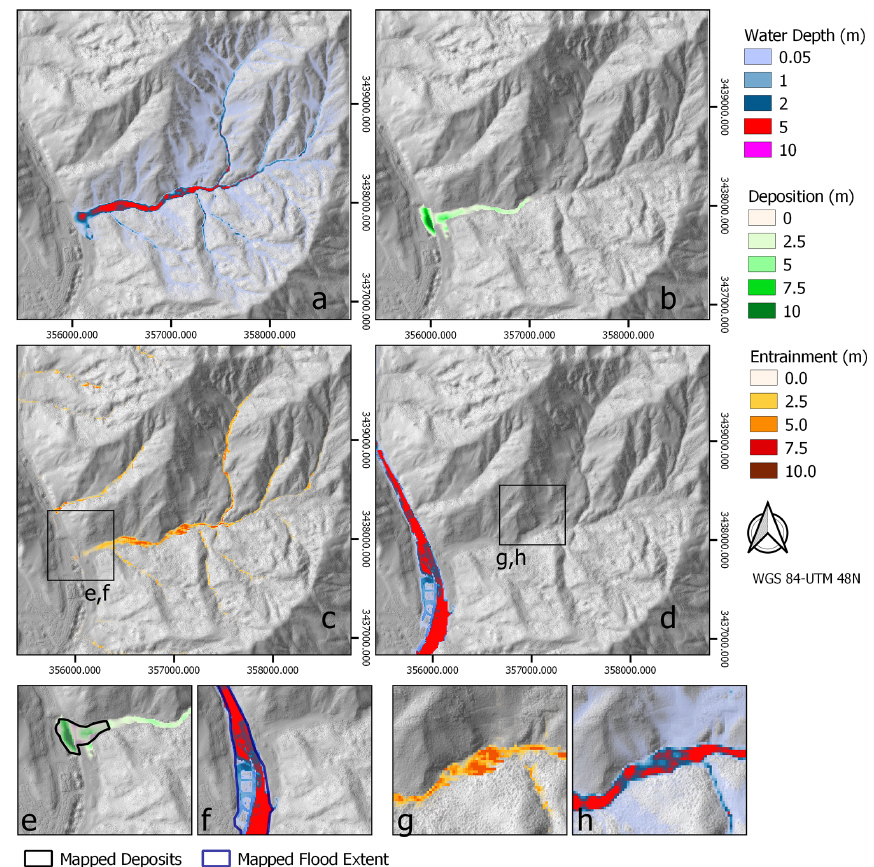
Figure 11. Calibrated simulation results for the second chain in the Hongchun watershed. (A) Maximum total flow depth. (B) Final deposit depth. (C) Entrainment depth. (D) River flood depth. (E, F) Zoom of Hongchun outlet with (E) deposition depth compared with mapped extent and (F) river flood depth compared to mapped flood extent. (G, H) Zoom of Hongchun landslide dam with (G) entrainment depth and (H) maximum flow